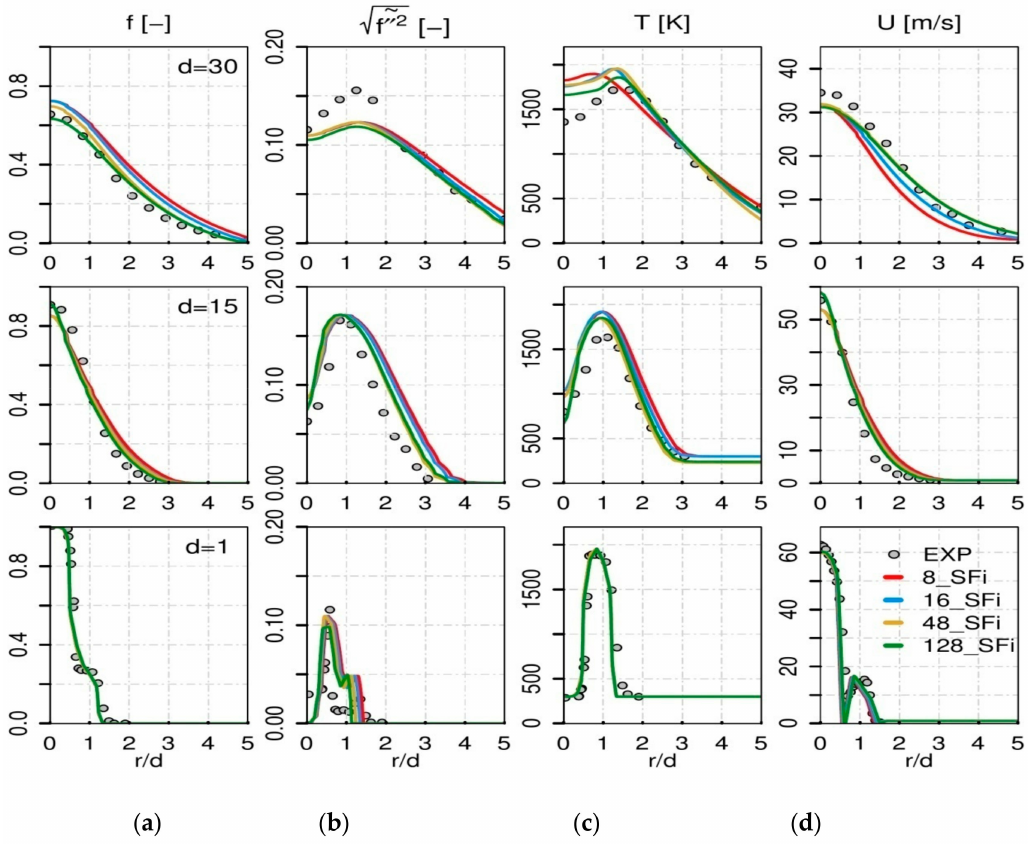
Figure 4. Comparison between experimental data for Flame-D [16] and RANS numerical results for different numbers of SFi at different axial positions; d = 1, d = 15 and d = 30, ( a ) mean mixture fraction, ( b ) rms of mixture fraction, ( c ) mean temperature and ( d ) mean